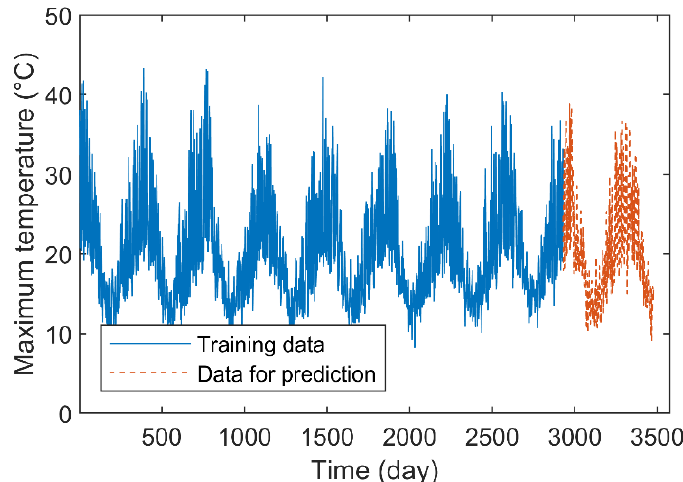
Figure 9. Time series of daily maximum temperature.